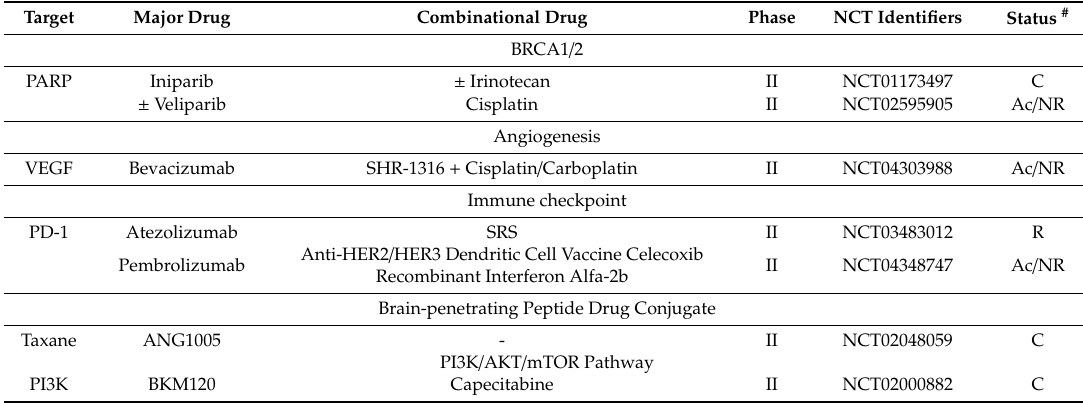
Table 1. The clinical trials in triple-negative breast cancer with brain metastasis